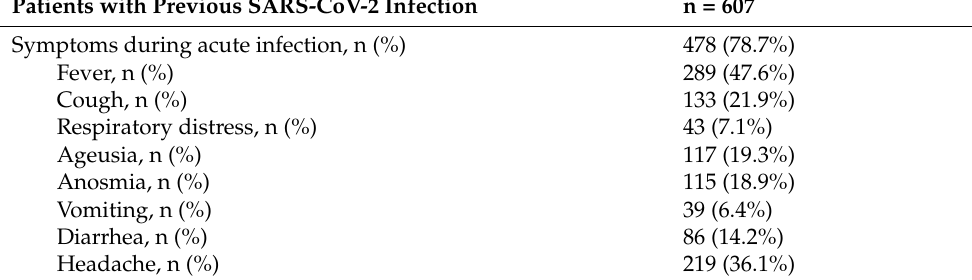
Table 1. Cont. Patients with Previous SARS-CoV-2 Infection n = 607 Symptoms during acute infection, n (%) 478 (78.7%) Fever, n (%)